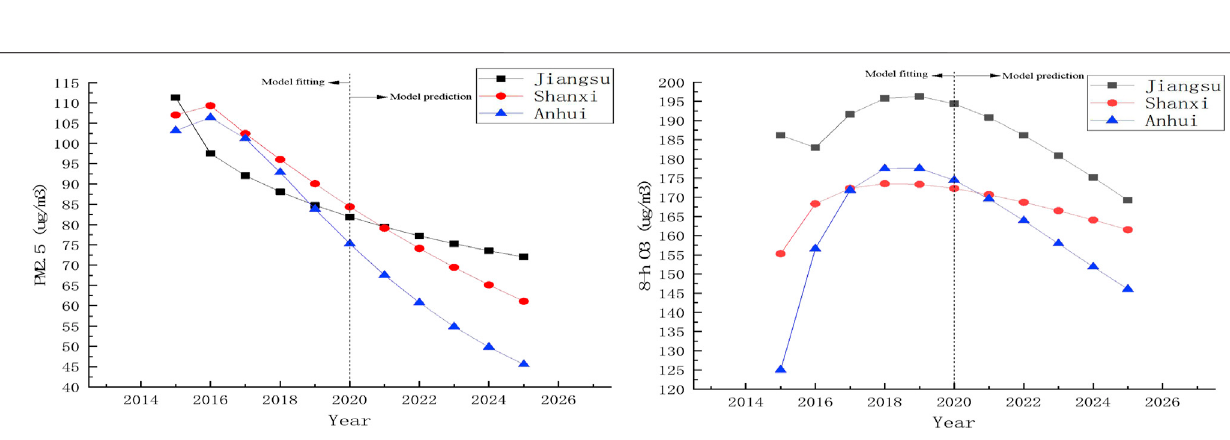
Frontiers in Environmental Science |